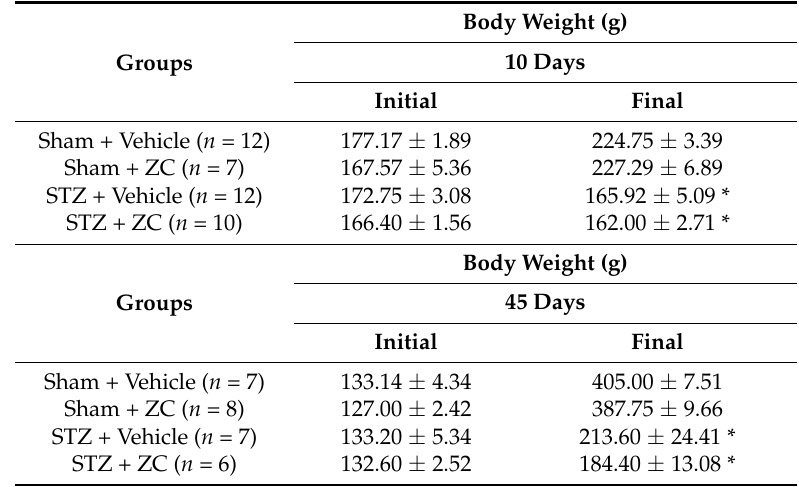
Table 1. Effect of zinc plus cyclo-(His-Pro) (ZC) on change in body weight of sham and streptozotocin (STZ)-induced diabetic rats. Values are means ± SE, n = 6–12 from each group; * p < 0.05, versus sham